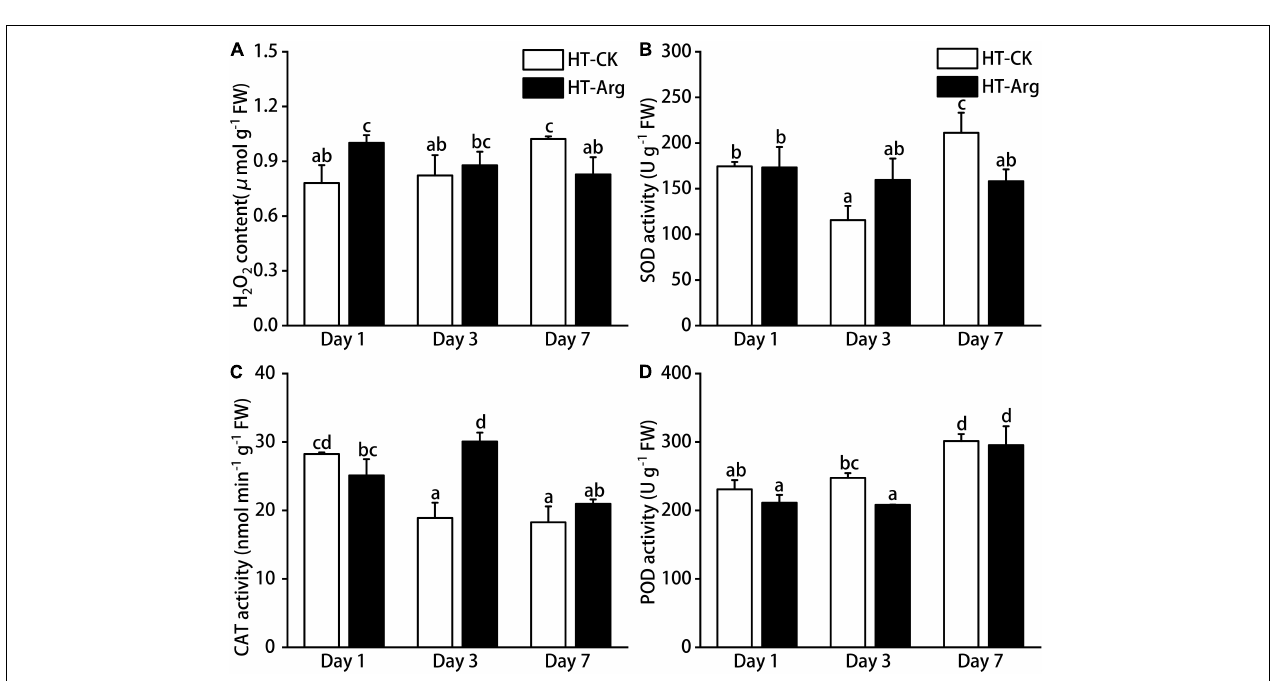
FIGURE 2 | Effect of L-arginine on ROS and antioxidant systems in G. lemaneiformis grown under high temperature with different treatments. (A) H 2 O 2 content; (B) superoxide dismutase (SOD) activities; (C) catalase (CAT) activities; and (D) peroxidase (POD) activities. Data presented are the means ± SD from three independent experiments, and different letters above the columns indicate a significant difference ( p < 0.05). ROS, reactive oxygen